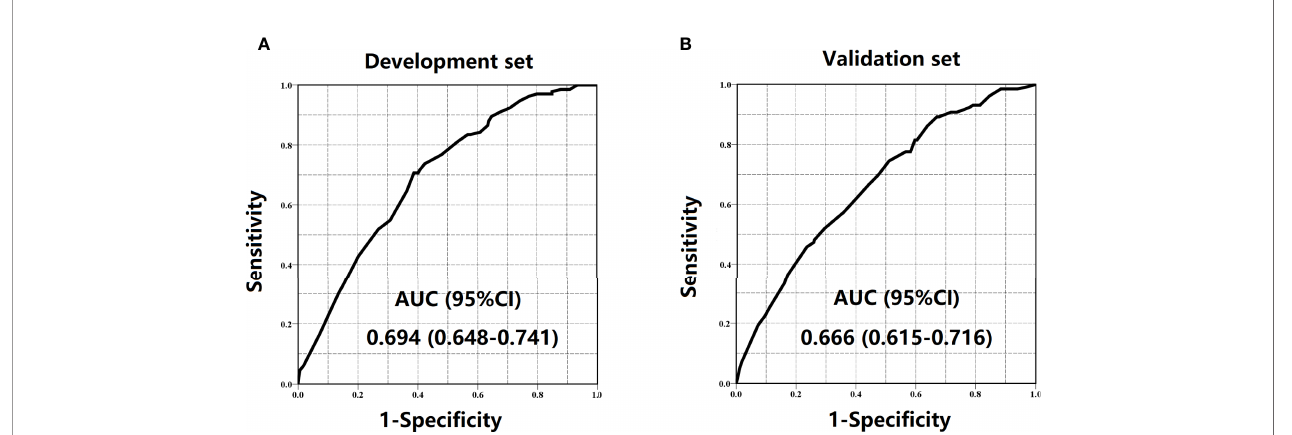
FIGURE 4 | ROC curves in the (A) development set and (B) validation set.